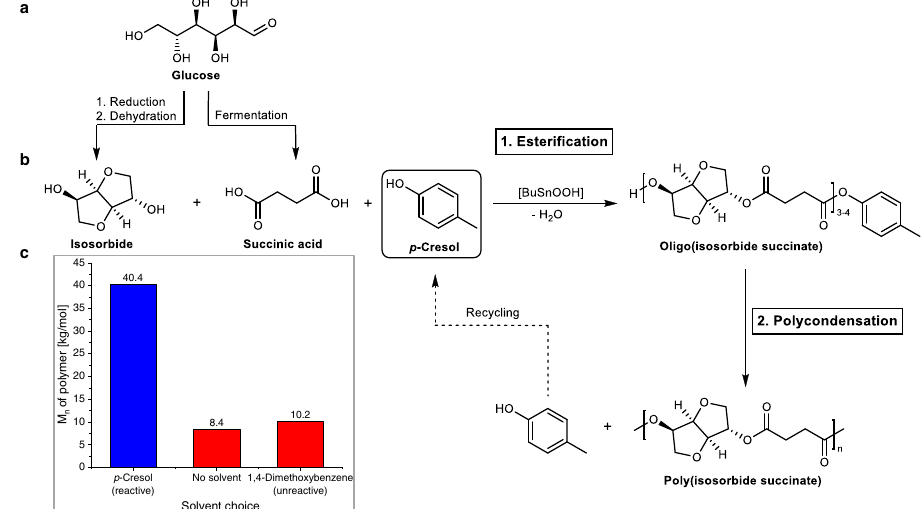
Fig. 2 | Synthesis of high molecular weight PIsSu with aryl alcohol. a Monomer synthesis fromglucose,obtainable fromeither fi rstor second-generationbiomass. b SynthesisofPIsSufromsuccinicacid,isosorbideand p -cresol(seeFig.3formore